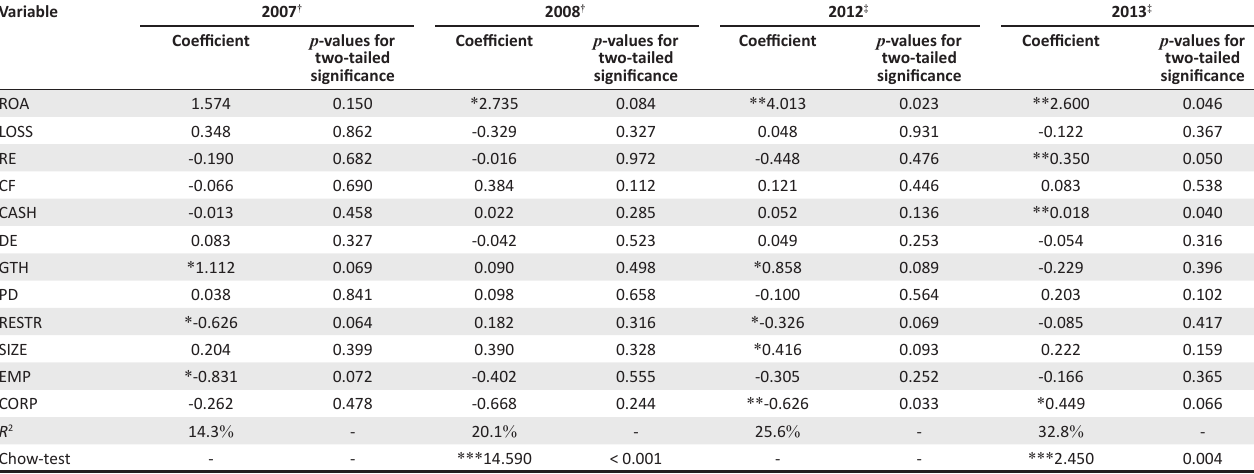
TABLE 6: Controlling for cross-sectional correlation.